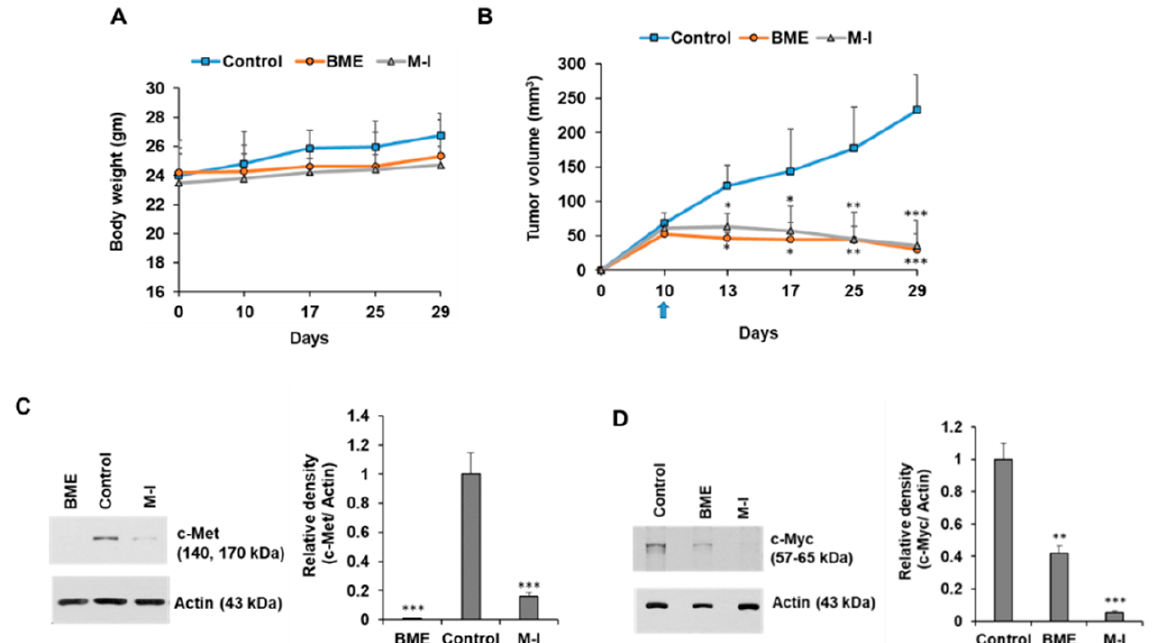
Figure 7. Therapeutic effect of momordicine-I in Cal27 xenograft model. Cal27 cells (1.5 × 10 6 ) cells were injected subcutaneously into the flank of nude mice. After formation of palpable tumor, mice were randomly divided into three groups ( n = 5): Control (without any treatment), BME group (30% BME through drinking water) and M-I group (30 mg/kg IP, once in a day and every day). ( A ) Body weight was measured in control and treated mice. ( B ) Tumors were measured using a slide caliper and tumor volumes were calculated. Arrow indicates starting point BME/ M-I treatment. ( C , D ) Control or treated tumor lysates were subjected to Western blot analysis for c-Met and c-Myc expression using specific antibodies and representative bands are shown. The blot was reprobed with an antibody to Actin for normalization. Right panel shows quantitation. Small bar indicates standard error (*, p < 0.05; **, p < 0.01; *** p < 0.001). Uncropped western blots figures are shown in Figure